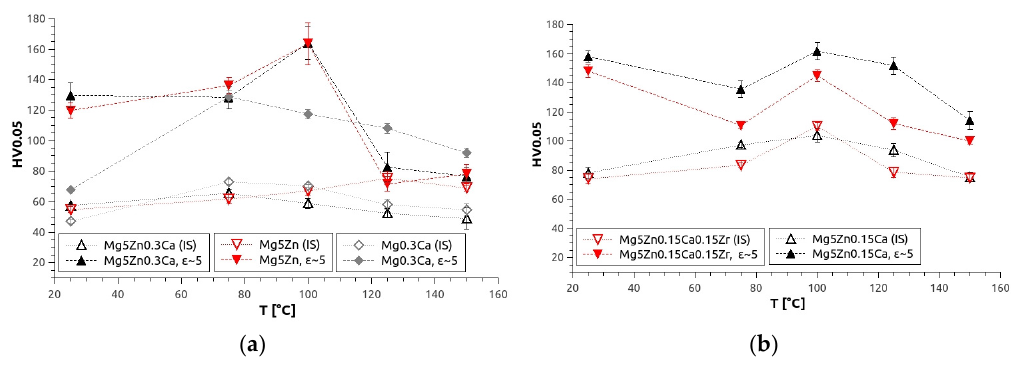
Figure 10. Results of microhardness measurements of Mg alloys in the IS (furnace ‐ cooled) and after HPT ‐ processing at 4 GPa and 0.5 rotations, and additional heat treatment for 24 h at varying temperatures. ( a ) Mg5Zn0.3Ca (black), Mg5Zn (red) and Mg0.3Ca (grey); and ( b ) Mg5Zn0.15Ca0.15Zr (red) and Mg5Zn0.15Ca (black).